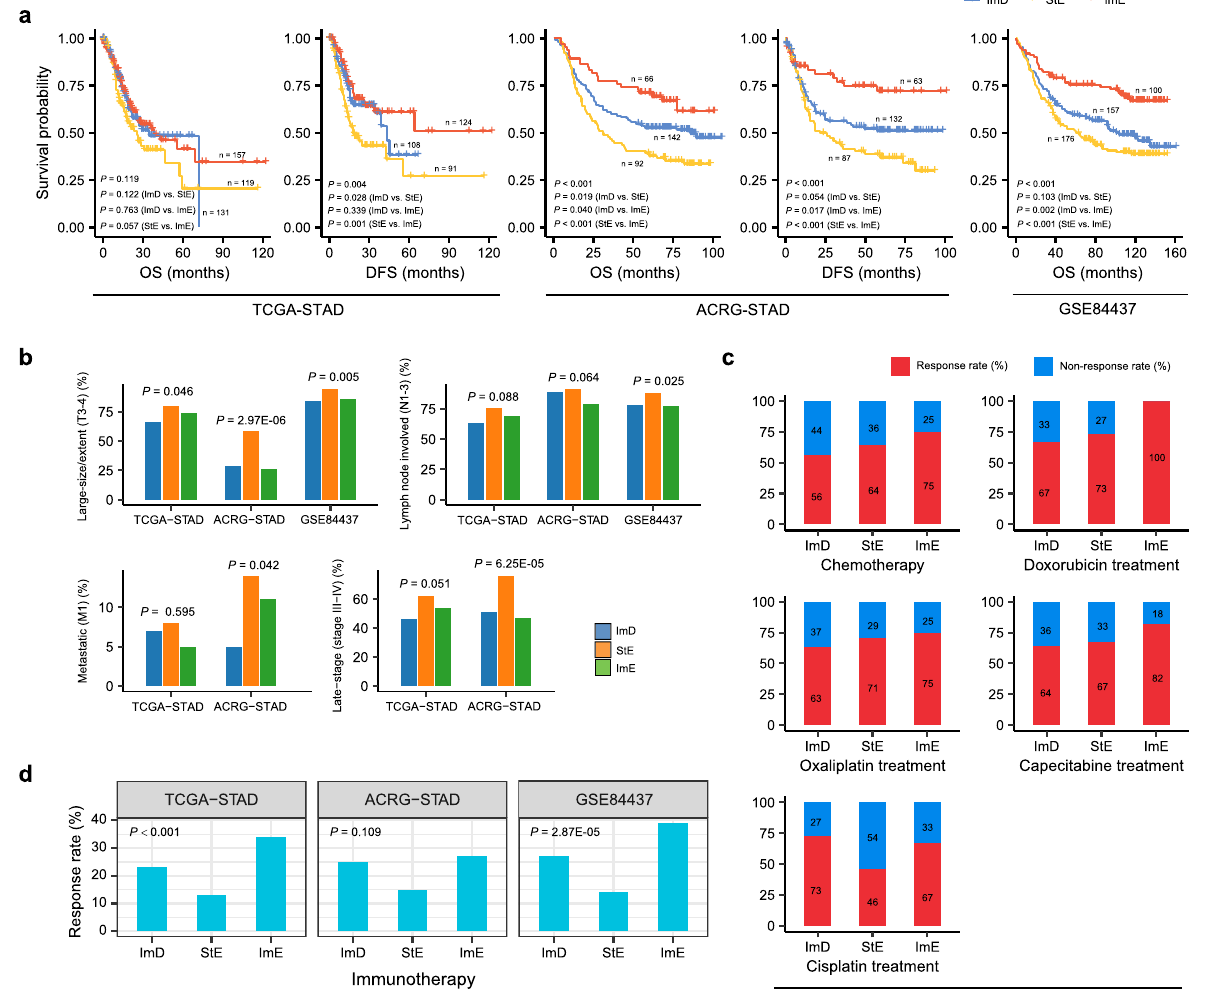
Fig. 7 Comparisons of clinical features between the three GC subtypes. a Kaplan – Meier curves showing that ImE and StE tend to have the best and worst survival prognosis, respectively. The log-rank test P values are shown. DFS disease-free survival. b StE harbors a higher proportion of advanced (large size/extent (T3 – 4), lymph nodes involved (N1 – 3), metastatic (M1), or late-stage (stage III – IV)) tumors than ImD and ImE. The Fisher ’ s exact test P values are shown. c Comparisons of the response (complete or partial response) rates of chemotherapy (30 drugs combined) and four individual chemotherapies (doxorubicin, oxaliplatin, capecitabine, and cisplatin) between the GC subtypes. ImE showing the highest response rate of chemotherapy (combined), doxorubicin, oxaliplatin, and capecitabine; ImD showing the highest response rate to cisplatin. d ImE and StE having the highest and lowest response rates to immune checkpoint inhibitors, respectively, predicted by the TIDE algorithm 68 . Fisher ’ s exact test P values are